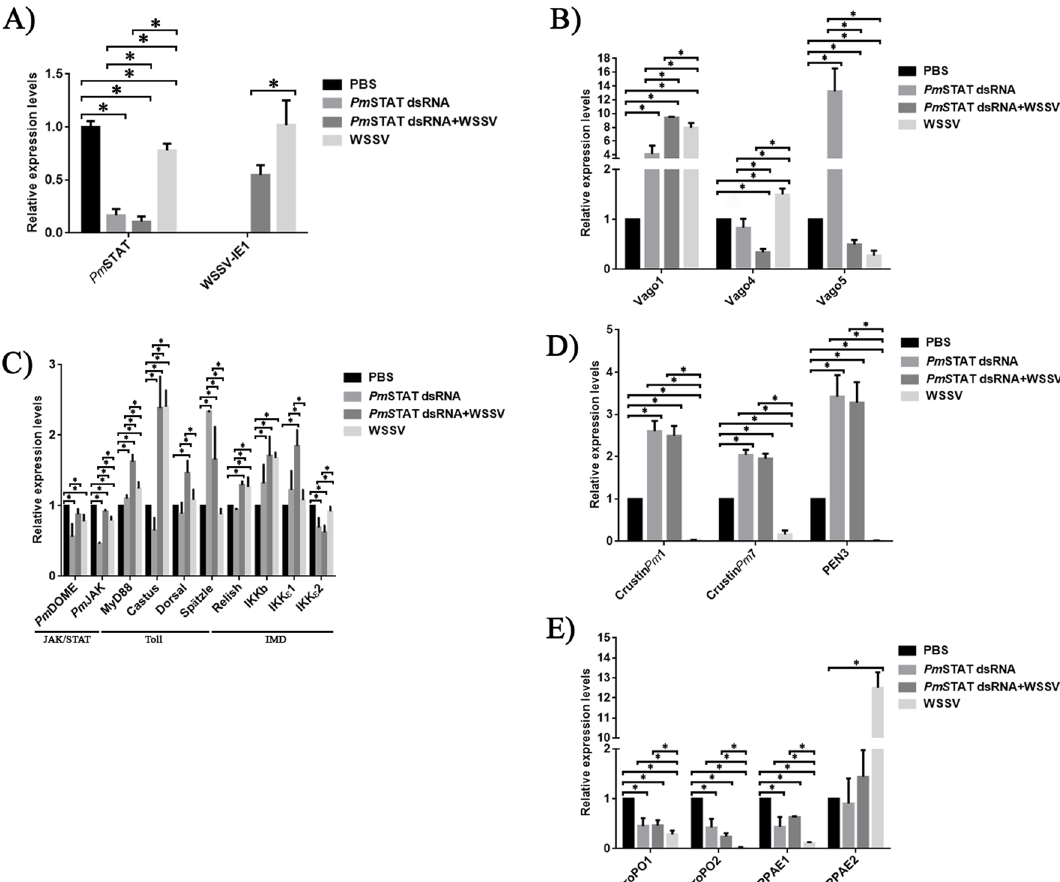
Figure 1. ( A ) Pm STAT and IE1 transcription levels in shrimp intestine at 24 h post-WSSV injection. Pm STAT was suppressed by injecting Pm STAT dsRNA 10 µg per shrimp’s gram, then 16 h later, followed by the same amount with the first injection. The control group was injected with PBS instead Pm STAT dsRNA. WSSV was injected at 24 h after the 2nd Pm STAT dsRNA injection. Shrimp intestines were collected at 24 h post-infection. In addition, we investigated the transcription levels of immune-related genes upon Pm STAT silencing during WSSV infection. ( B ) Transcription levels of interferon-like gene ( Pm Vago 1, 4, and 5). ( C ) Expression levels of immune-related genes, including JAK/STAT pathway ( Pm DOME and Pm JAK), Toll pathway (MyD88, Castus, Dorsal, and Spätzle), IMD pathway (Relish) and inhibitor of kappa B kinase (IKKβ, IKKε1, and IKKε2). Moreover, Transcription levels of immune genes were also observed. ( D ) Transcription levels of antimicrobial peptide and ( E ) phenol oxidase